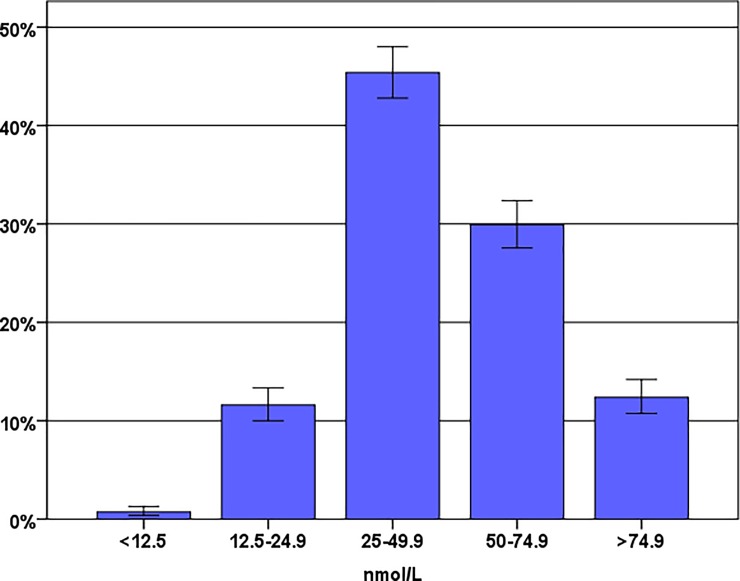
Distribution of serum 25OHD concentrations in pregnant women at the time of delivery.